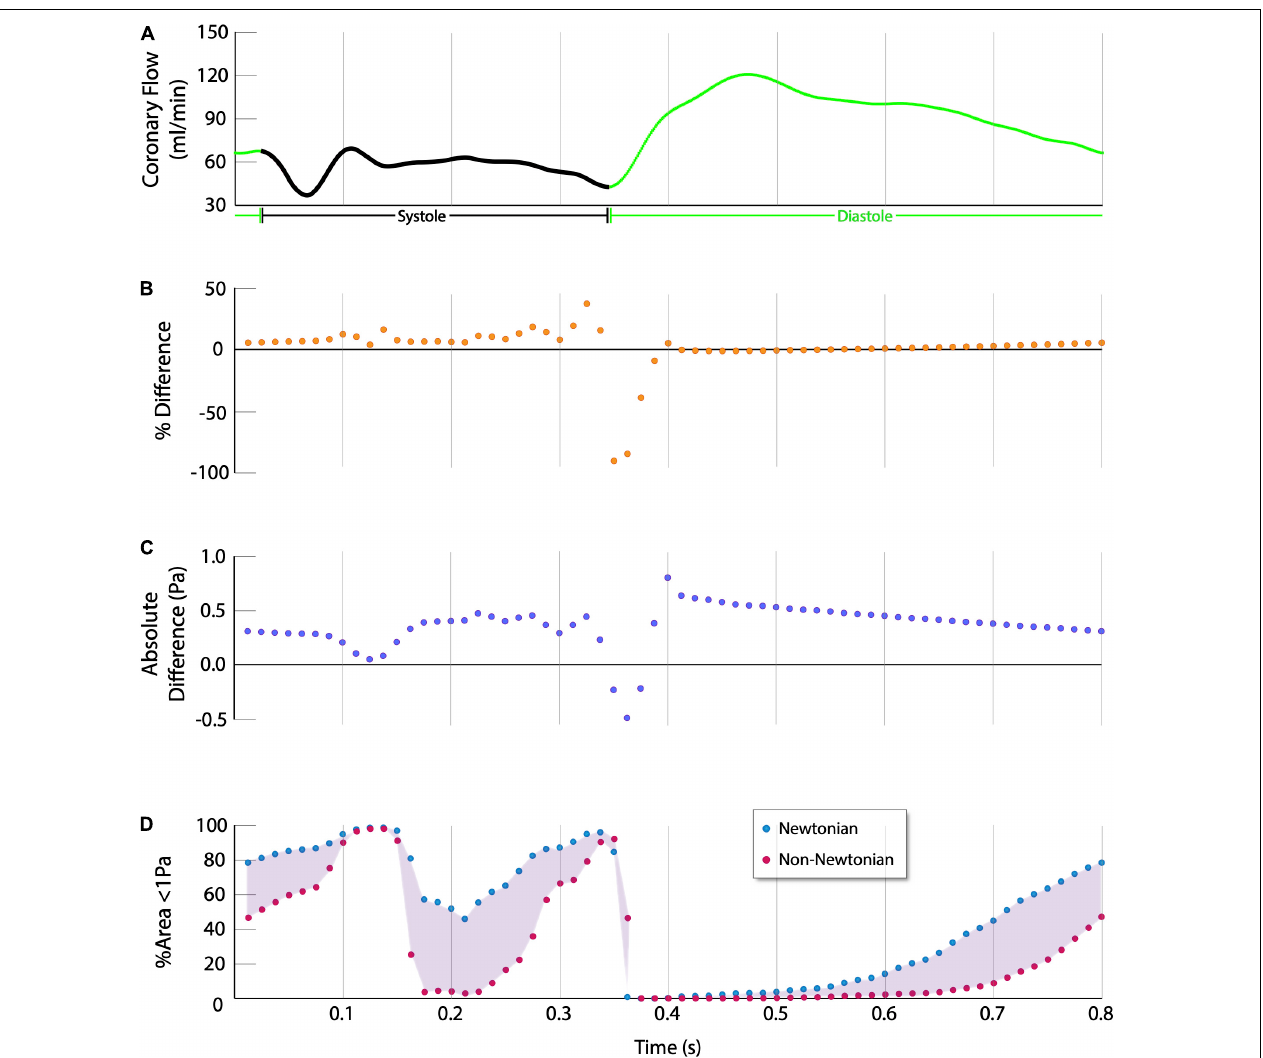
FIGURE 4 | Quantitative difference in ESS between Newtonian and non-Newtonian models (Single Representative Case). (A) Coronary flow rate, systole is indicated in black, diastole is indicated in green. (B,C) The % difference and absolute difference are calculated as (non-Newtonian ESS – Newtonian ESS), thus positive values indicate non-Newtonian results were higher whereas negative values indicate higher Newtonian results. The non-Newtonian results show consistently higher percent normalized difference and absolute difference in ESS over the cardiac cycle, except during the momentary transition between systole and diastole at approximately 0.35s. (D) Newtonian simulations predict more of the vessel is exposed to atherogenic levels of ESS over the cardiac